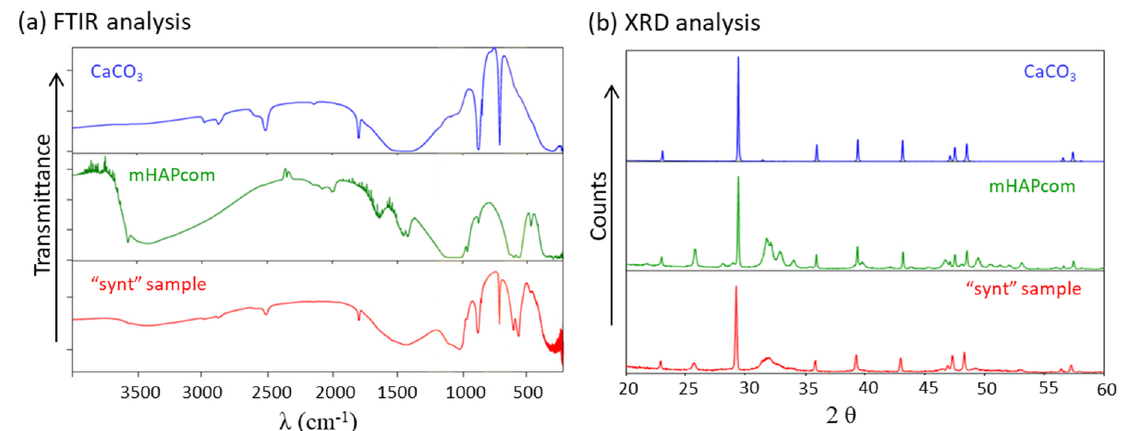
Figure 1. FTIR spectra ( a ) and the XRD spectra ( b ) of the selected synthesized material and, for comparison, calcite and a commercial HAP (mHAPcom).